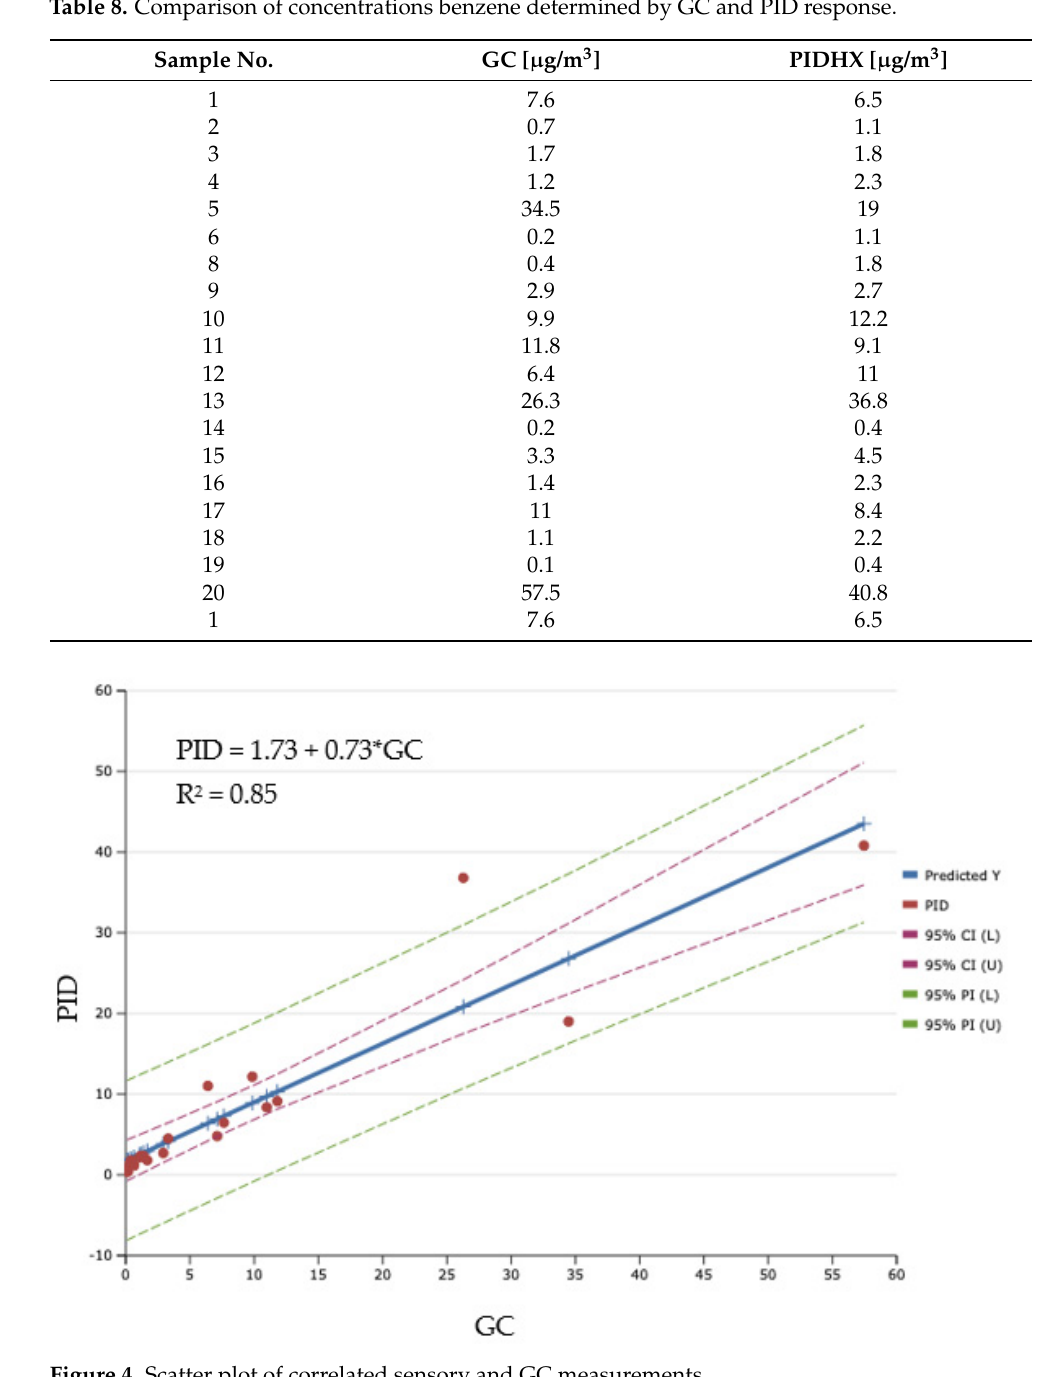
Figure 4. Scatter plot of correlated sensory and GC measurements. Table 9 contains an overview of the correlation coefficients between the PIDHX dataset and a different combination of VOCs. Due to a linear function-based calibration, adding more parameters (compounds) into the relation results in a decrease in correlation.